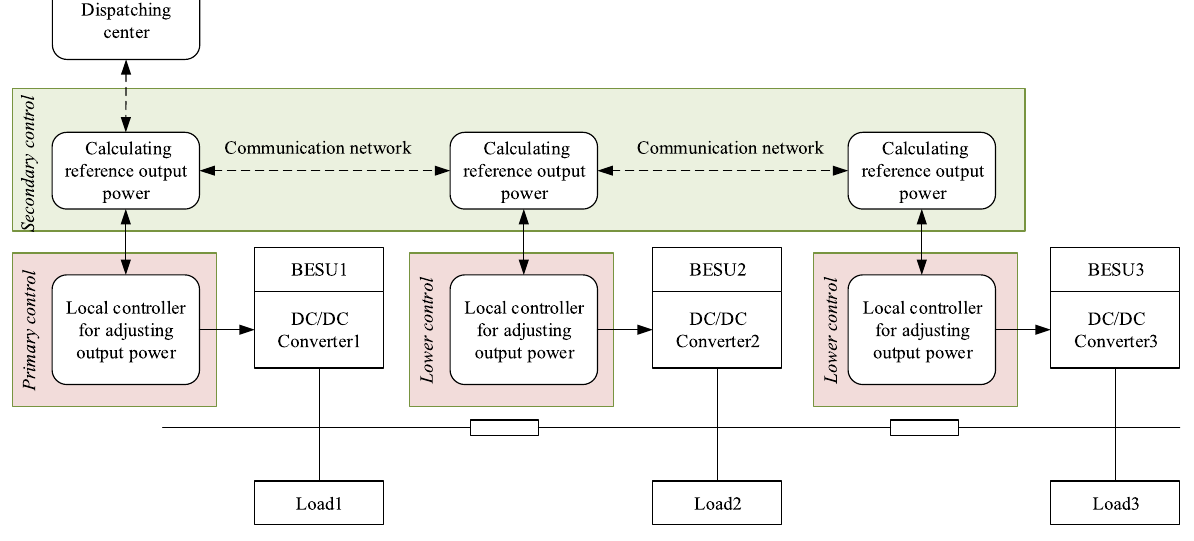
Fig. 3 Structure of the hierarchical distributed